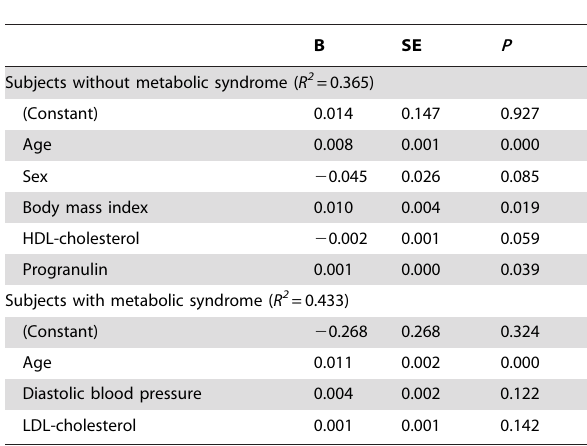
Table 3. Multiple Stepwise Regression Analyses for Determinant Factors Associated With Carotid Intima-Media Thickness in Subjects With or Without Metabolic